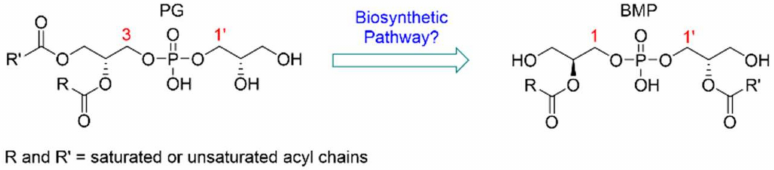
Figure 1. PG as a hypothesized precursor to